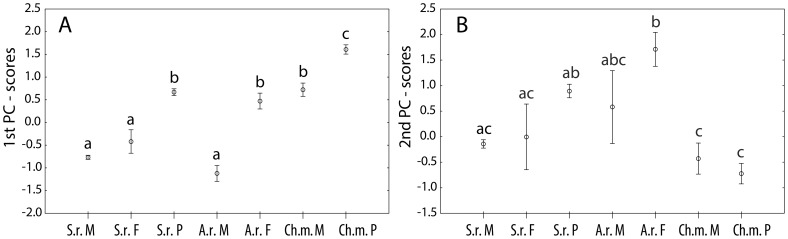
Multivariate analysis of stoichiometric relations in three species of xylophagous beetles (PCA).ANOVA computed independently for the 1st and 2nd axis scores A – ANOVA for scores of the 1st principal component (F6, 76 = 91.919, p = 0.0000); B – ANOVA for scores of the 2nd principal component (F6, 76 = 8.8204, p = 0.00000); vertical bars denote standard errors. Values bearing different letters denote significant differences in the elemental composition between species, sexes and pupae (unequal N, HSD test, p<0.05). S.r. M - Stictoleptura rubra males, S.r. F - Stictoleptura rubra females, S.r. P - Stictoleptura rubra pupae, A.r. M - Arhopalus rusticus males, A.r. F - Arhopalus rusticus females, Ch.m. M - Chalcophora mariana males, Ch.m. P - Chalcophora mariana pupae.